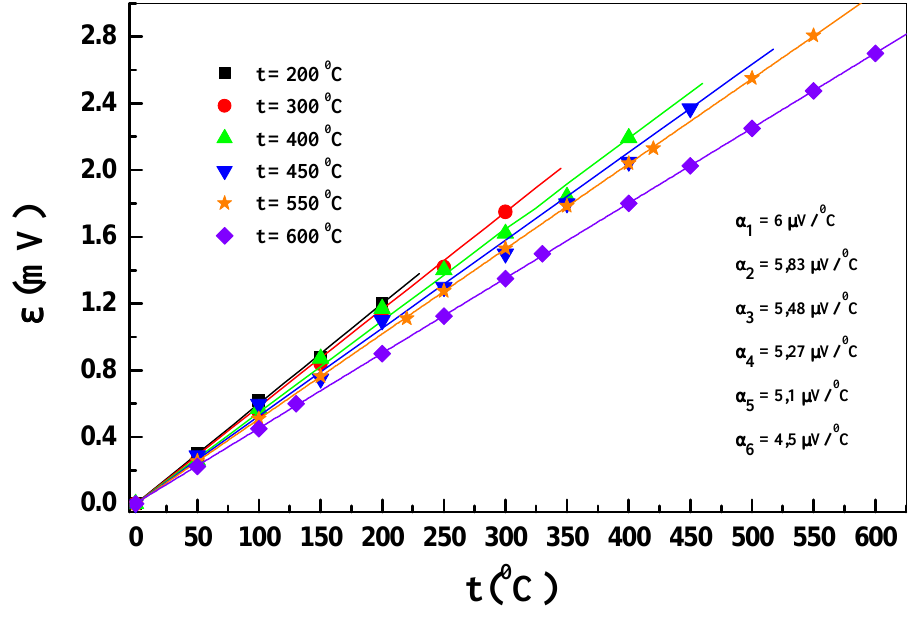
Figure 3. Thermoelectromotive force temperature dependence of the same sample of AMA Fe Cu Nb Si B during multiple heatings of up to temperatures t 73.5 1 3 15.5 7 = 400ºC, t t 3